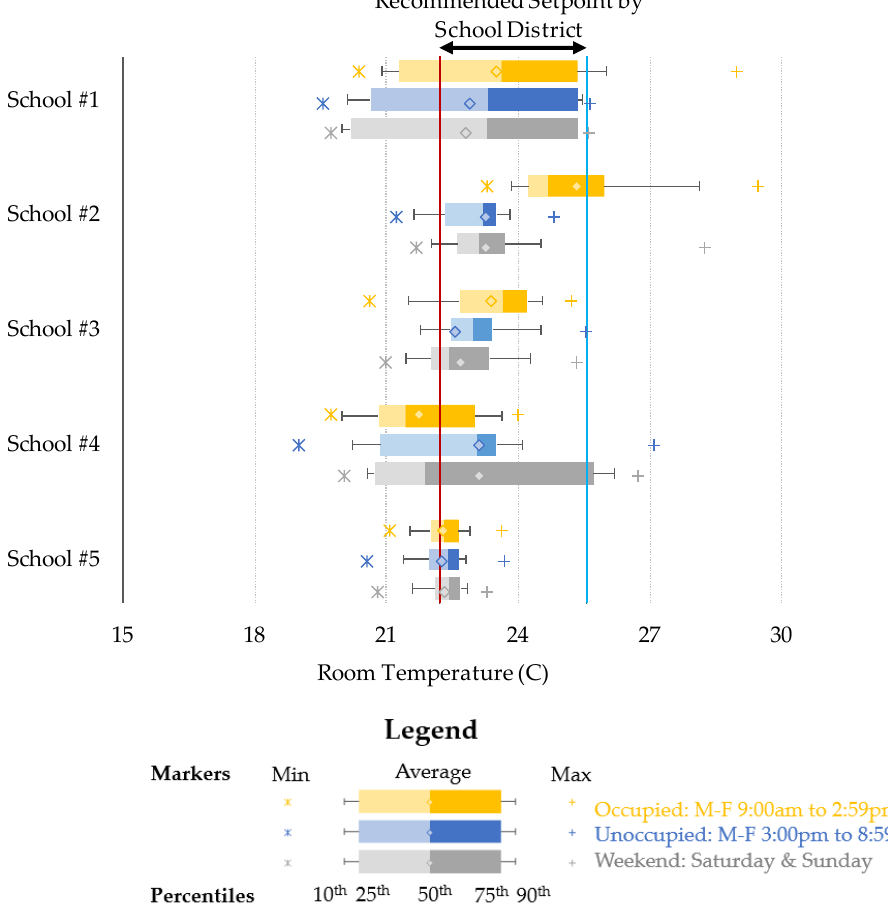
Figure 4. Classroom Temperature Statistical Distributions by Occupancy Mode. Table 8. Fishers LSD Analysis for Classroom Temperature by School.